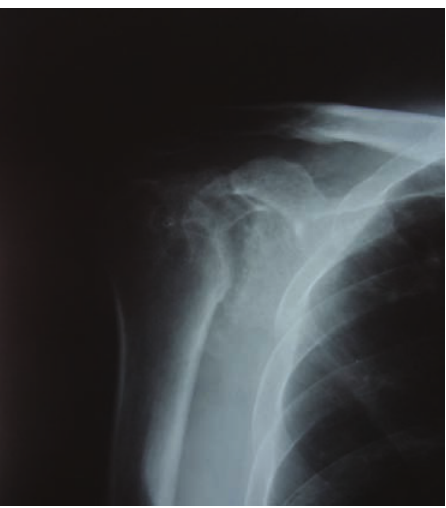
Figure 1: A plain radiograph showing severe glenohumeral joint destruction.